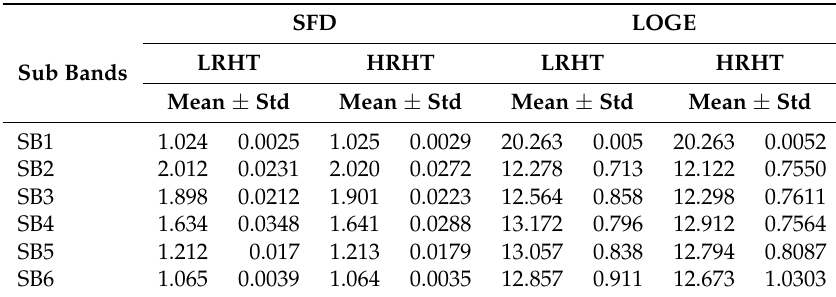
Table 4. Mean and standard deviation for CH1. SB, sub-band.